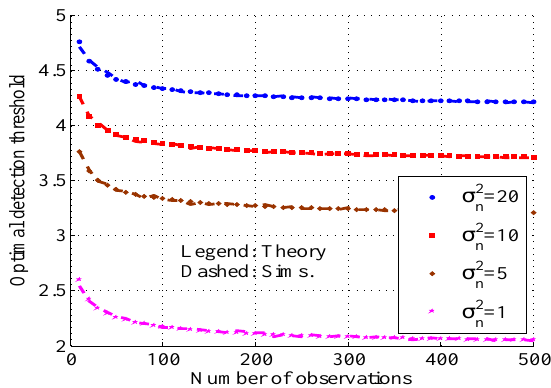
using (B.4) and from L